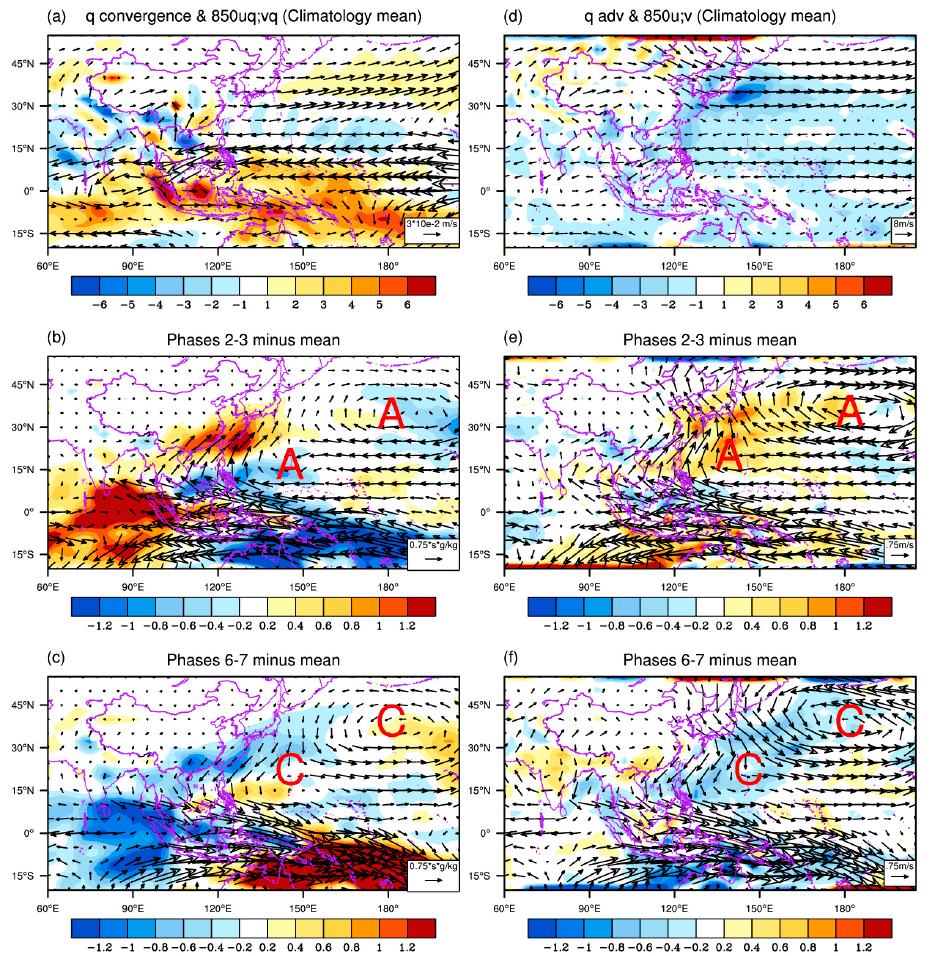
Figure 5. ( a ) Climatological mean of column-integrated moisture convergence (shading, positive is convergence and negative is divergence, unit: 10 − 5 kg/s·m 2 ) and 850-hPa moisture flux (vector, unit: 0.75·s·g/kg) for NDJFM. ( b ) Changes in moisture convergence and 850-hPa moisture flux during MJO phases 2–3 and ( c ) phases 6–7 with respect to climatology are also shown. ( d – f ) same as in ( a – c ) but the shadings represent column-integrated moisture advection and the vector represent 850-hPa winds.